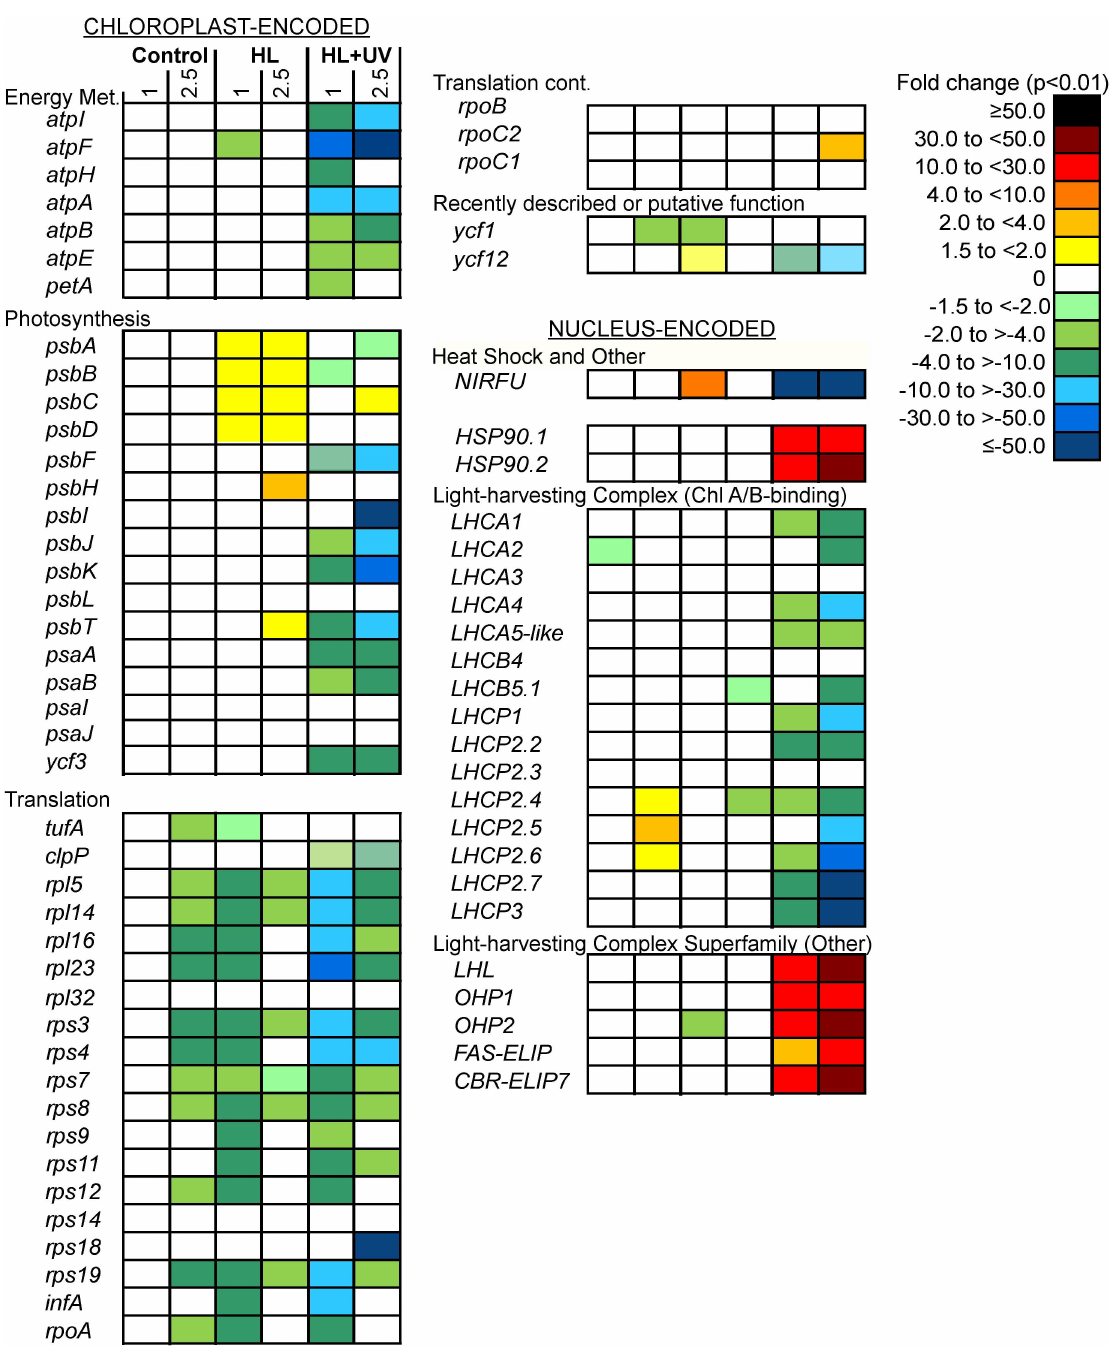
Fig 5. Expression changes for protein-encoding genes from the chloroplast genome and a subset of nuclear genes. HL and HL+UV data represent fold changesrelative to controls at the same time point, whileeach control time point is comparedto the precedingcontrol time point. Only genesthat met coveragecriteria and that displayedsignificantchanges( p < 0.01) (cid:21) 1.5-fold across the biologicaltriplicatesin at least one time point, relativeto controls at the same time point (this figure), or relative to T 0 (Fig A in S1 File), are shown. Note that all LHCs and LIL as well as HSP90.2 (XP_002507383)and NIRFU (XP_002507511) proteins have transit peptidestargeting them to the chloroplast, as predictedusing TargetP.